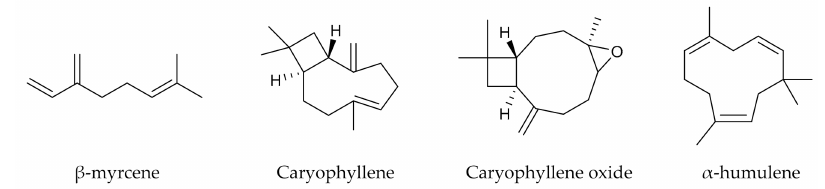
Figure 4. Notable terpenes of cannabis essential